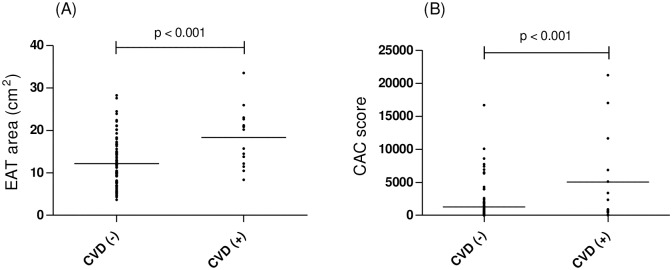
Comparison of EAT area and CAC score between COPD patients with and without CVD.The EAT area (A) was measured using ImageJ software Ver.1.47, and the CAC score (B) was evaluated using the Agatston method. The EAT areas and CAC scores were higher in the COPD patients (p < 0.001).